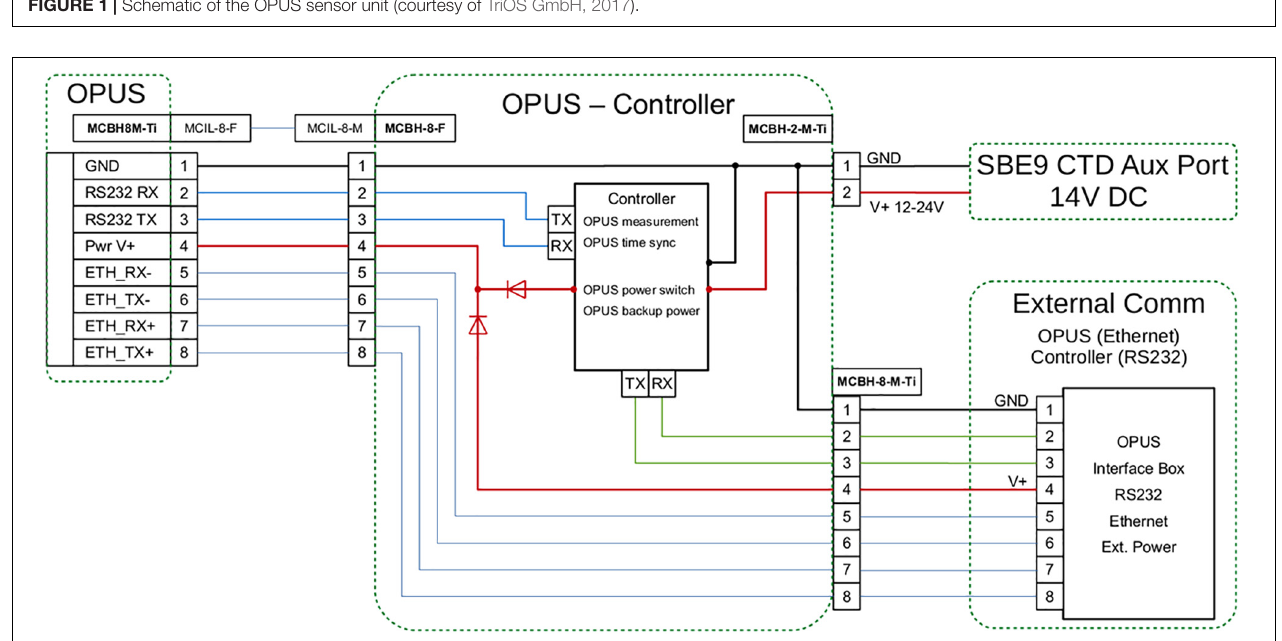
FIGURE 1 | Schematic of the OPUS sensor unit (courtesy of TriOS GmbH, 2017).